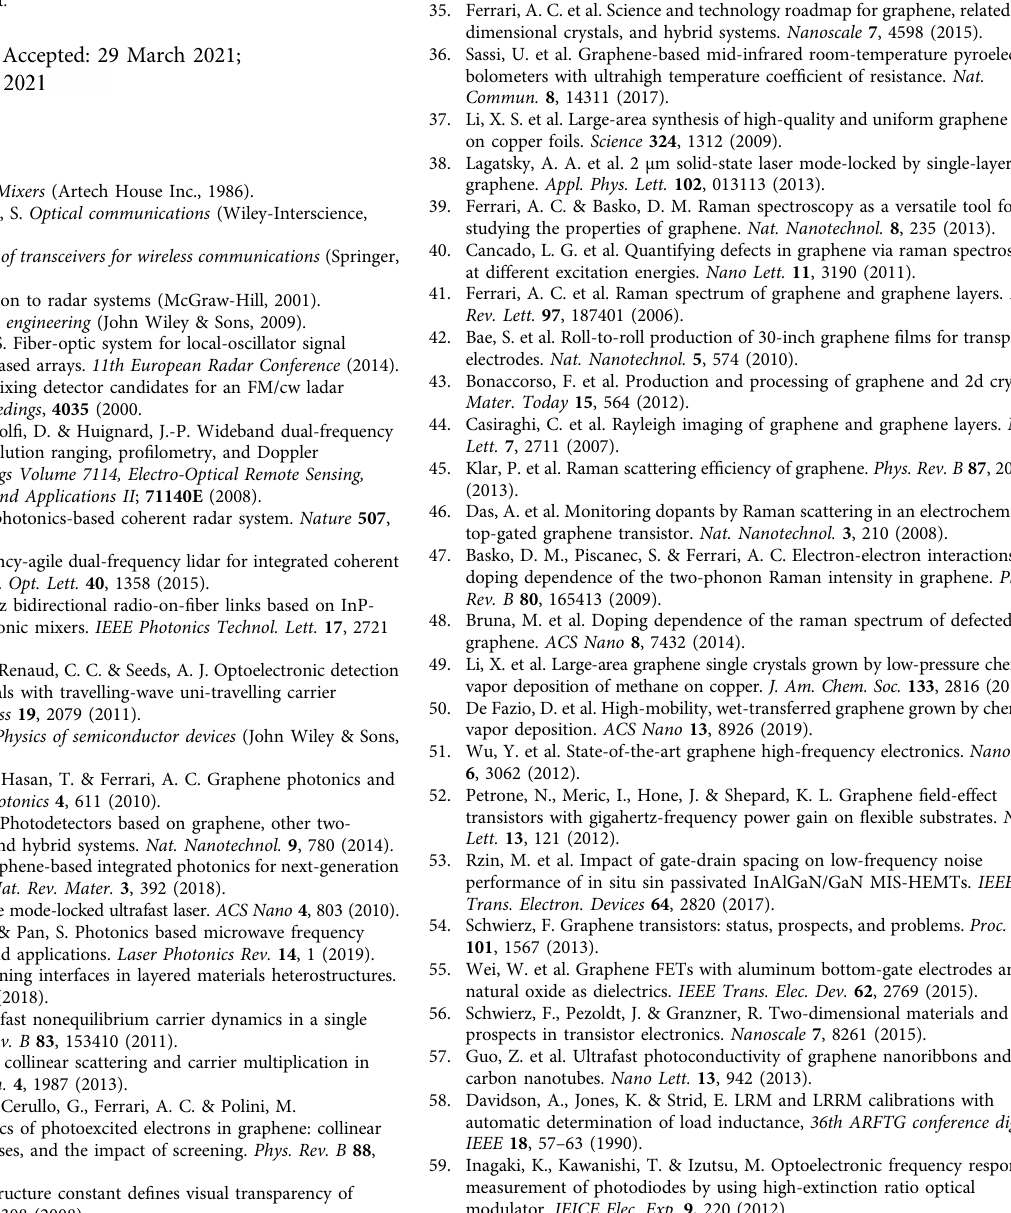
Fig. 9 plots the downconverted photocurrent at three frequencies as a function of V GS . This shows Fig. 6 is valid regardless of operating frequency. Dependence of the laser spot position on photoresponse . Figure 10 shows the photoresponse as a function of laser spot position over the device, along the dashed black line. The photocurrent is measured with the VNA used for the RF mea- surements in Fig. 2a. The optical beam intensity is modulated at 10GHz and the optical power impinging the sample is ~10mW. The beam scan step is ~300nm, smaller than the spot size of the laser ~2 μ m, as de fi ned by the FWHM of the intensity of the Gaussian laser pro fi le. The red dots represent the measured pho- tocurrent at V DS = 0.2V, whereas the blue ones are for V DS = 0 V. The maximum photocurrent is registered when V DS = 0.2V and the laser spot is over the GFET channel. We observe very low photocurrent, comparable with the instrument noise fl oor (~ − 90 dBm electrical power detected over the internal 50 Ω impedance of the instrument) at V DS = 0. At V DS = 0.2V, we do not observe a change of the pho- tocurrent sign (due to, e.g., asymmetrical heating effect 73 ) when the laser spot is scanned from the source to the drain contact. Thus, the role of contacts in the photocurrent generation can be